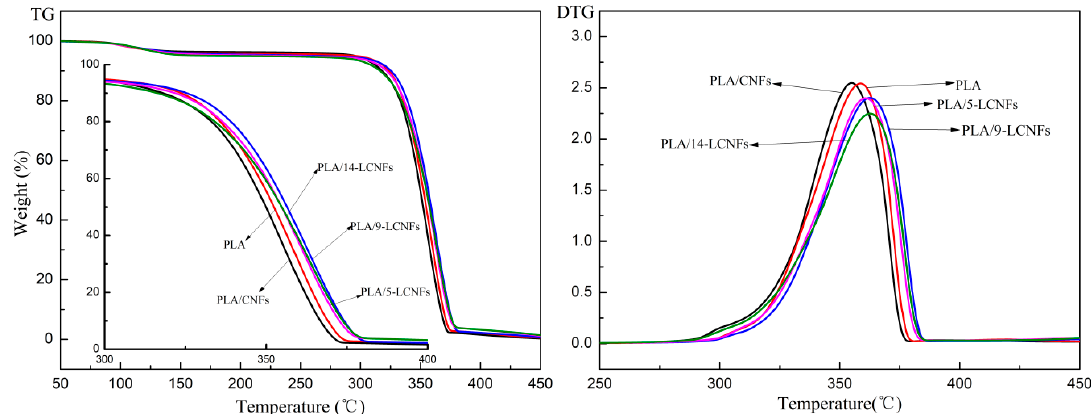
Figure 5. TG and DTG curves of PLA and the PLA/LCNFs composites.